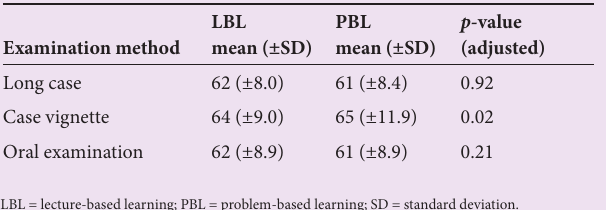
Table 2. Examination